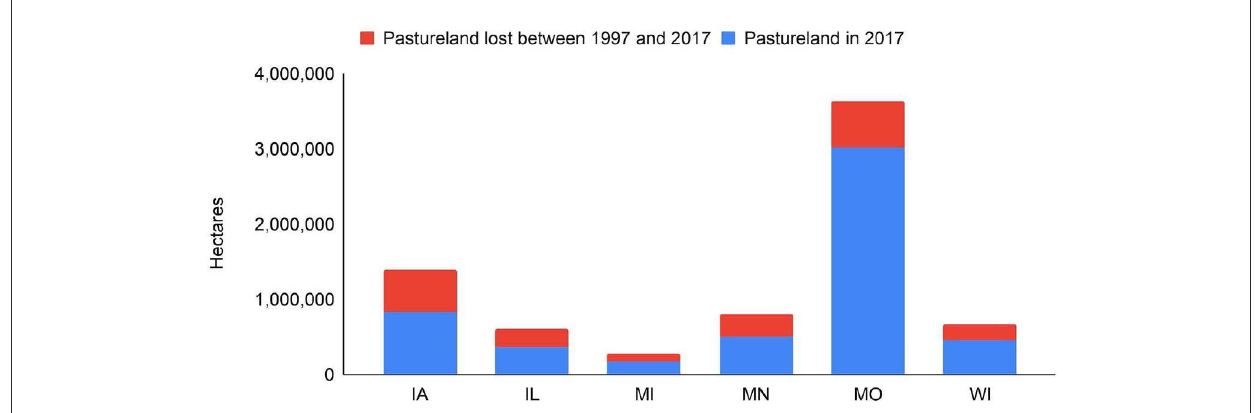
FIGURE1 Non-woodland pasture declined across the Upper Midwest between 1997 and 2017. Data source: Agricultural Census 1997 and 2017 (USDA National Agricultural Statistics Service, 1997,